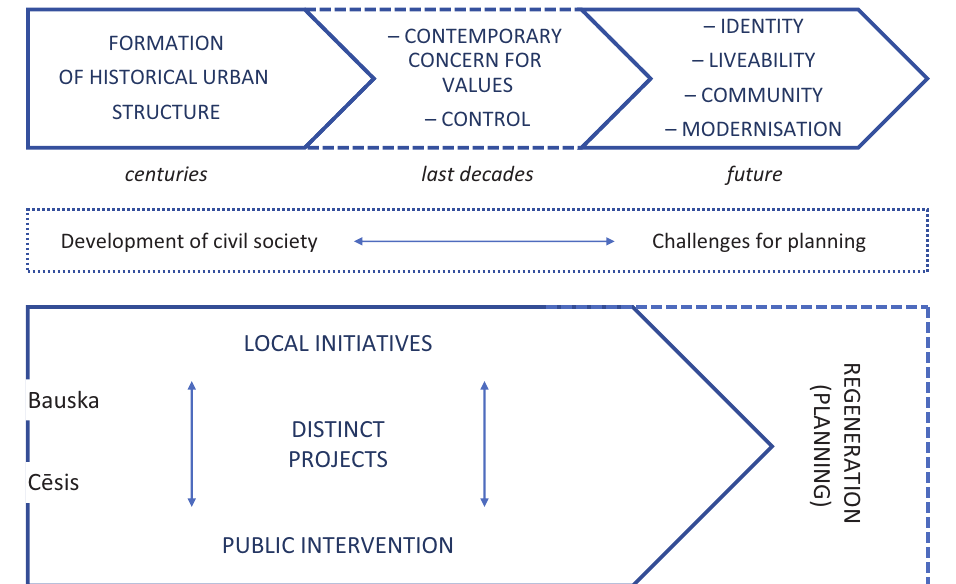
Figure 10. Development processes, enablers, and challenges for planning in two Latvian